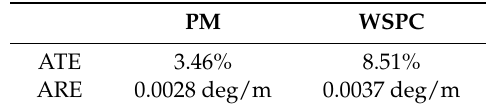
Table 2. Comparison of ego-motion estimation error in scenario 1.